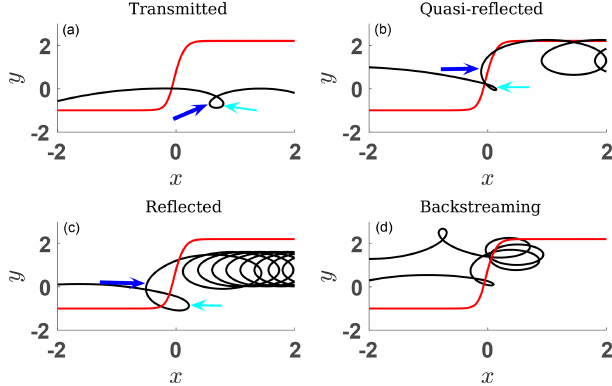
Figure 4. Various kinds of x − y trajectories . The magnetic field shape (not to scale) is shown by the red lines, the cyan arrows show first turning point, and the blue arrows show the second turning